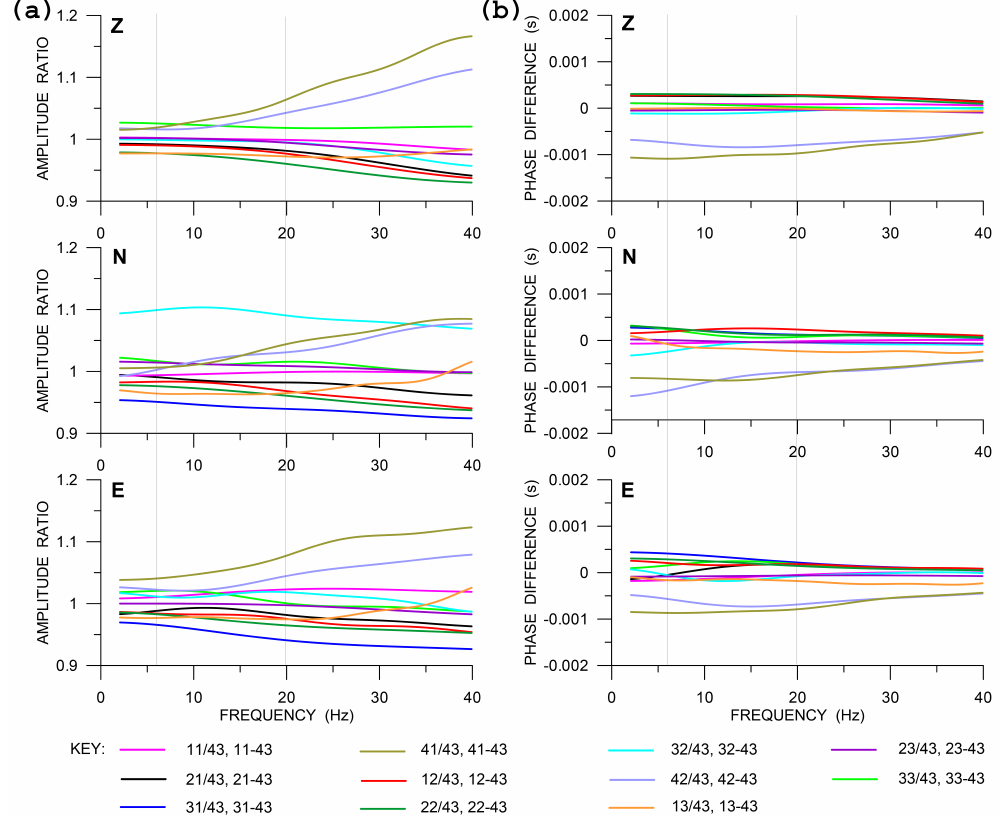
Figure 8. Amplitude ratios ( a ) and phase differences ( b ) of the individual LE-3DLite sensors with respect to the reference one for vertical (Z), North (N) and East (E) components. The thin vertical grey lines mark the frequency range actually considered in the comparative experiment. Two-digit sensor identifiers shown in Figure